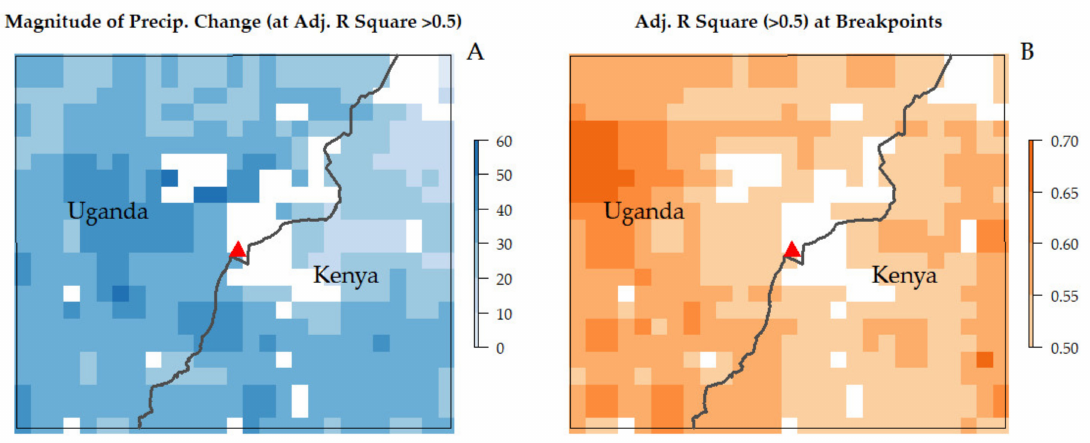
Figure 10. ( A , B ) Adjusted R2 (greater than 0.5) and magnitude of change in the precipitation time series (2001–2008) using 2005–2008 as the monitoring